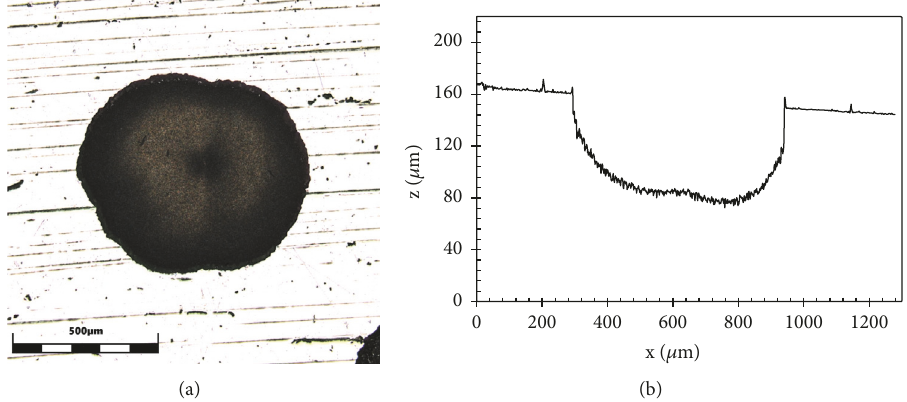
Figure 11: CLSM micrograph of a pit (a) and its corresponding transverse profile (b) for a representative NK